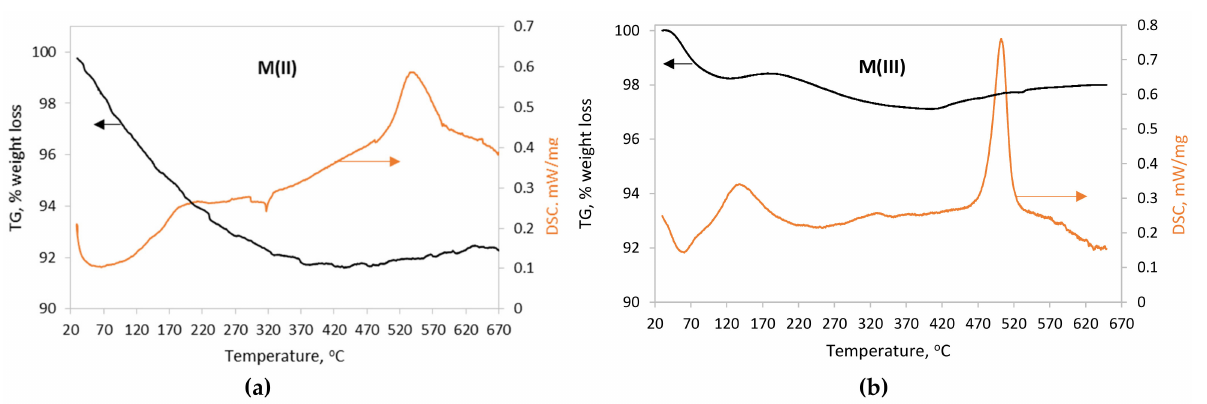
Figure 5. TG/DSC patterns of nanoiron particles ( a ) M(II) and ( b )